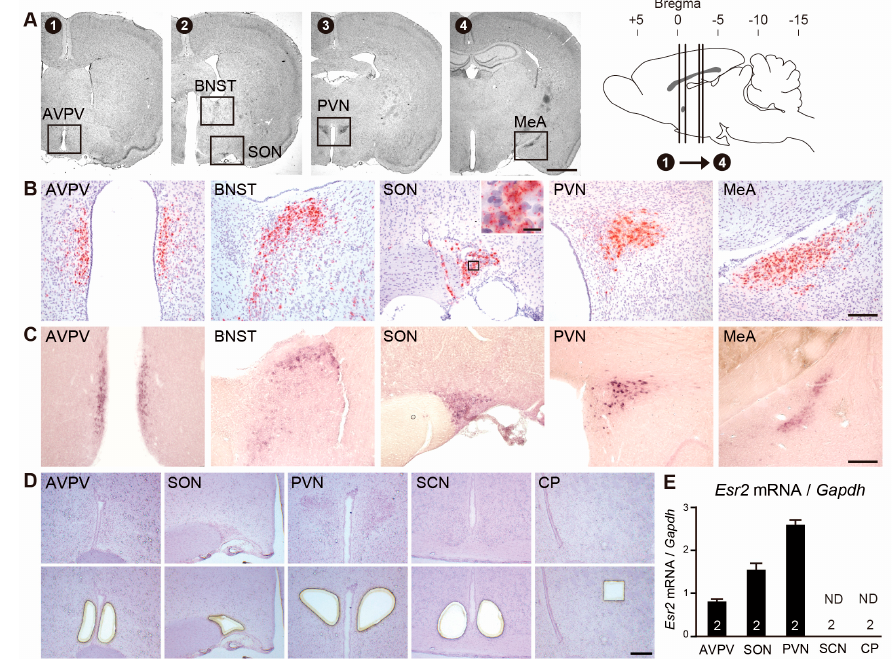
Figure 1. Comparison of Esr2 signals by RNAscope with Esr2 signals by conventional in situ hybridization (ISH) and expression levels of Esr2 mRNA by qPCR. ( A ) Nissl-stained images (1–4) and schematic sagittal brain section demonstrate the rostro-caudal levels of the rat brain. Insets in the Nissl-stained images show anatomical loci of the AVPV, BNST, SON, PVN, and MeA. Representative photomicrographs of Esr2 mRNA signals by RNAscope ( B ) and by conventional ISH ( C ) in the AVPV, BNST, SON, PVN, and MeA. ( D ) Representative photographs exhibiting brain sections before (upper panels) and after (lower panels) isolation by laser-microdissection. Scale bars indicate 2 mm in all panels in A, and 200 µm in all panels in B, C, and D. Inset in the SON panel in B shows higher magnification of cells containing Esr2 signals (scale bar = 20 µm). ( E ) Quantification of the Esr2 mRNA in the micro-dissected samples by qPCR. Numbers in each column represent the number of animals used. Values are depicted as the mean ± standard error of the mean (SEM). ND indicates “not-detected”. AVPV: anteroventral periventricular nucleus; BNST: bed nucleus stria terminalis; SON: supraoptic nucleus; PVN: paraventricular nucleus of the hypothalamus; MeA: medial amygdala; SCN: suprachiasmatic nucleus; CP: corpus striatum.